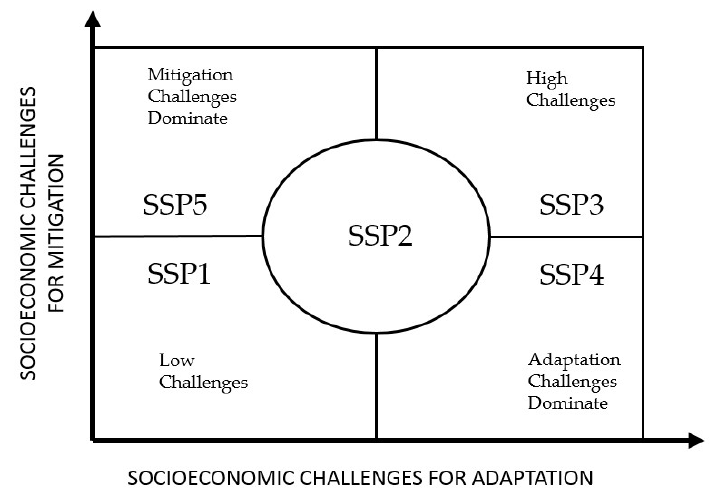
Figure 1. A New Scenario Framework for Climate Change Research; Source: [27].